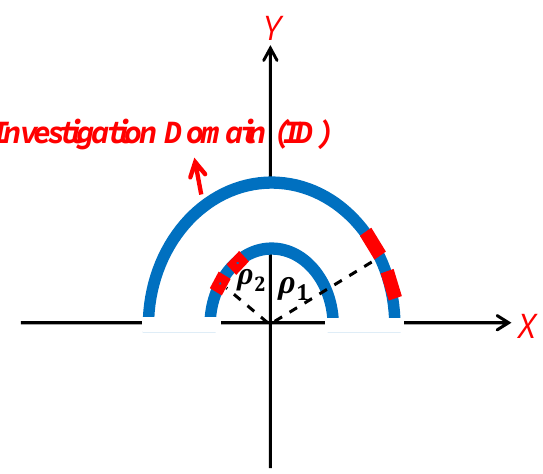
Figure 18. The geometry of the dielectric object (blue color) with cracks (red color).